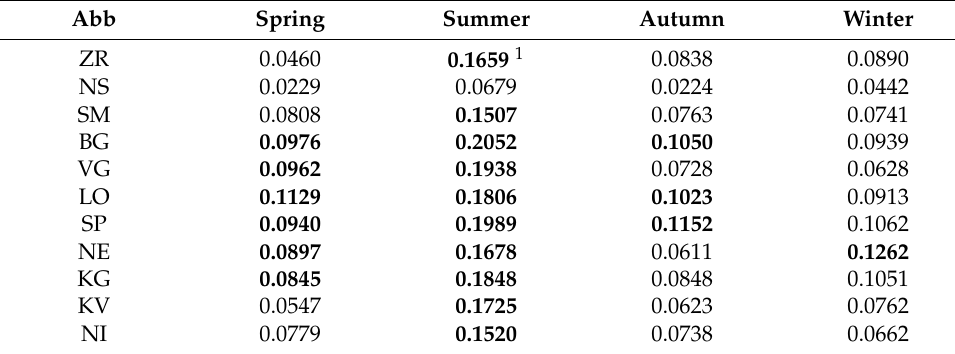
Table 4. Seasonal trend coefficients of Tx90 for 11 stations in Serbia from 1949 to 2018.